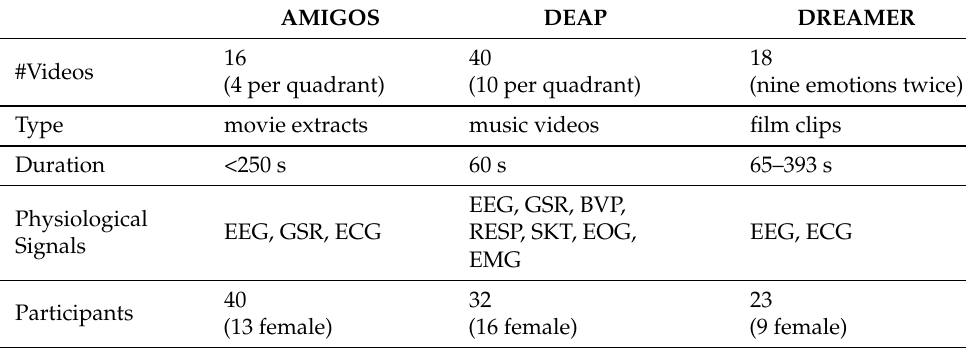
Table 2. Main characteristics of the AMIGOS, DEAP and DREAMER